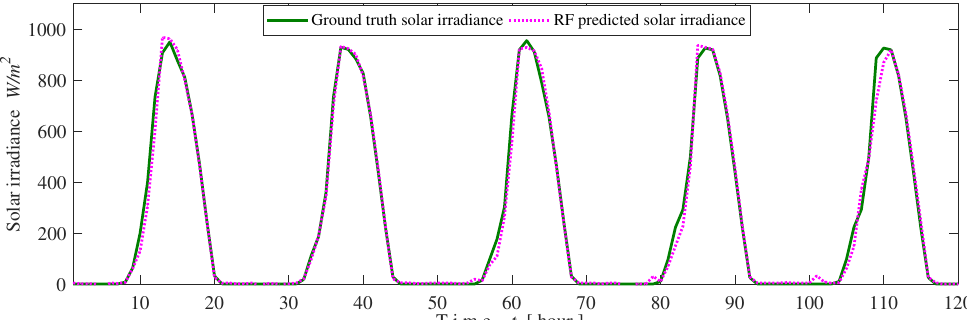
Figure 7. A graphical comparison of the actual versus the forecasted wind speed with one-time step ahead rolling horizon using Random Forest (RF) forecasting model for n = 800 (1/12/2018 to 5/12/2018).